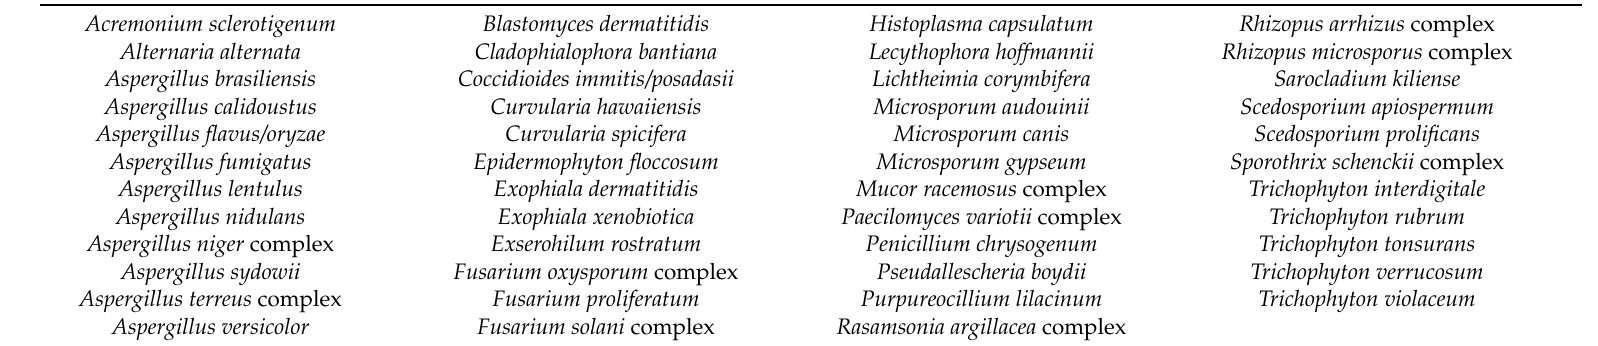
Table 2. Reportable filamentous and dimorphic fungi for the FDA-approved/cleared Vitek MS system as of October 2018